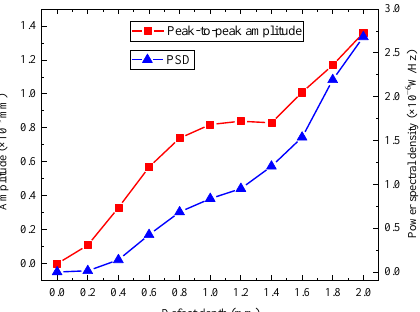
Figure 29. The influence of defect depth on the received signal (reflected wave).